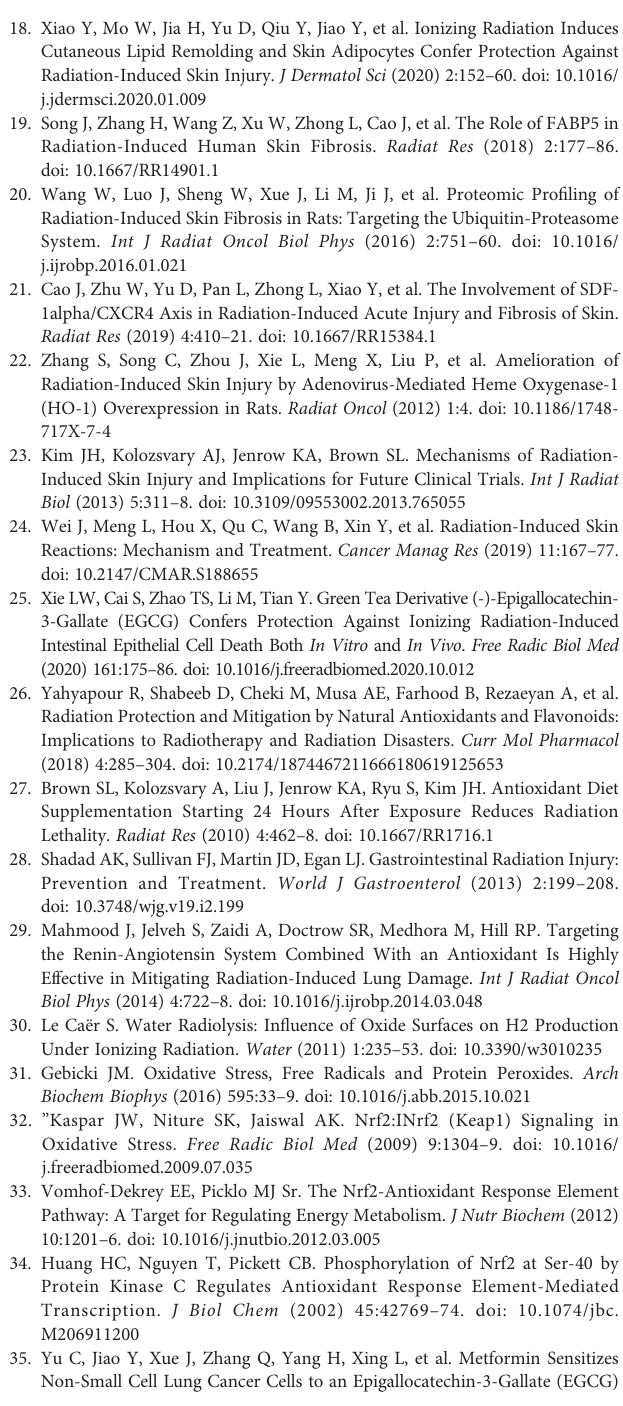
Supplementary Figure 2 | (A) Radiation-induced skin injury induced by electron beam irradiation (10 Gy) in WT (Nrf2 +/+ ) and Nrf2-de fi cient (Nrf2 -/- ) mice at 3 days post irradiation. (B) Radiation-induced skin injury induced by electron beam irradiation (10 Gy) in WT (Nrf2 +/+ ) and Nrf2-de fi cient (Nrf2 -/- ) mice at 10 days post irradiation. Supplementary Figure 3 | ROS levels in skin fi broblast WS1 cells after IR and Nrf2 overexpression were detected using a ROS-sensitive DCF-DA probe.